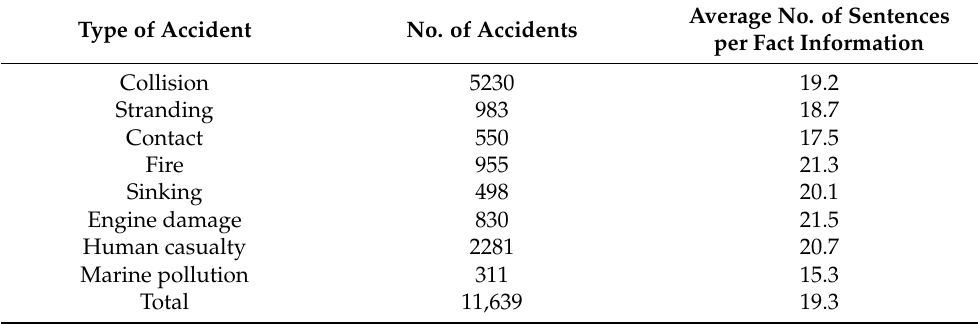
Table 2. Statistics of selected data of the